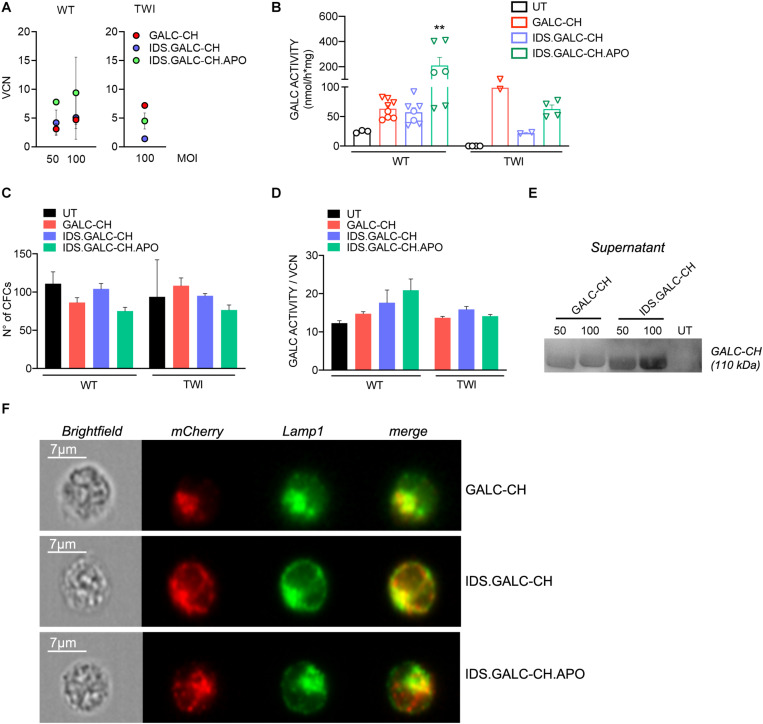
LV-transduced HSPCs and progeny express and secrete the chimeric GALC enzymes. (A) Vector copy number (VCN) measured in WT and TWI HSPCs 14 days after transduction with the different LVs at 50 and/or 100 MOI (liquid cultures). Data are expressed as the mean (n < 3) or the mean ± SEM (n ≥ 3). (B) GALC activity measured in UT and LV-transduced WT and TWI HSPCs (liquid cultures). O 50 MOI; ▽ 100 MOI. Data are the mean ± SEM, n = 4 independent experiments in duplicate/triplicate. One Way Anova followed by Dunnet’s multiple comparison test, **p<0.01 vs. UT WT. (C) Number of colonies (assessed in the CFU assay) generated by UT and LV-transduced WT and TWI HSPCs. Data are expressed as the mean ± SEM, n = 4 independent experiments in duplicate. (D) GALC activity normalized on VCN measured in UT and LV-transduced WT and TWI HSPCs (liquid cultures). Data are expressed as the mean ± SEM, n = 4 independent experiments in duplicate/triplicate. (E) Representative WB showing the GALC-CH protein (anti-mCherry antibody) in the supernatant of TWI HSPCs (liquid cultures) transduced with LV.GALC-CH and LV.IDS.GALC-CH at 50 and 100 MOI. The observed band of 110 kDa indicates the expression of the precursor GALC protein (80 kDa) fused with the mCherry protein (30 kDa). Supernatant collected from UT cultures serves as control. (F) Representative ImageStream pictures (brightfield and fluorescent channels) showing LAMP1 (green, pseudocolor) and mCherry (red, pseudocolor) proximity (merge) in TWI HSPCs (liquid cultures) transduced with LV.GALC-CH, LV.IDS.GALC-CH, and LV.IDS.GALC-CH.APO. Scale bar, 7 μm.